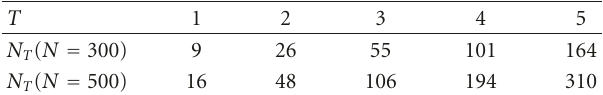
Table 1: N T , the number of neighbors within T hops, computed from ER model, used in Tests 1, 2, and 5.